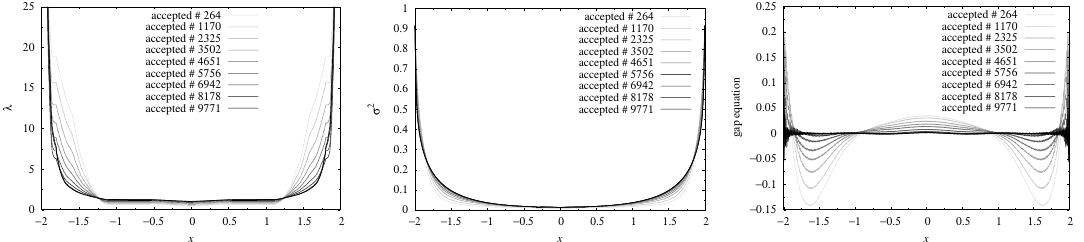
Figure 9 . Initial stage of the random walk: the algorithm tries to reduce the numerical error the most by bringing down (cid:27) (0) towards zero.